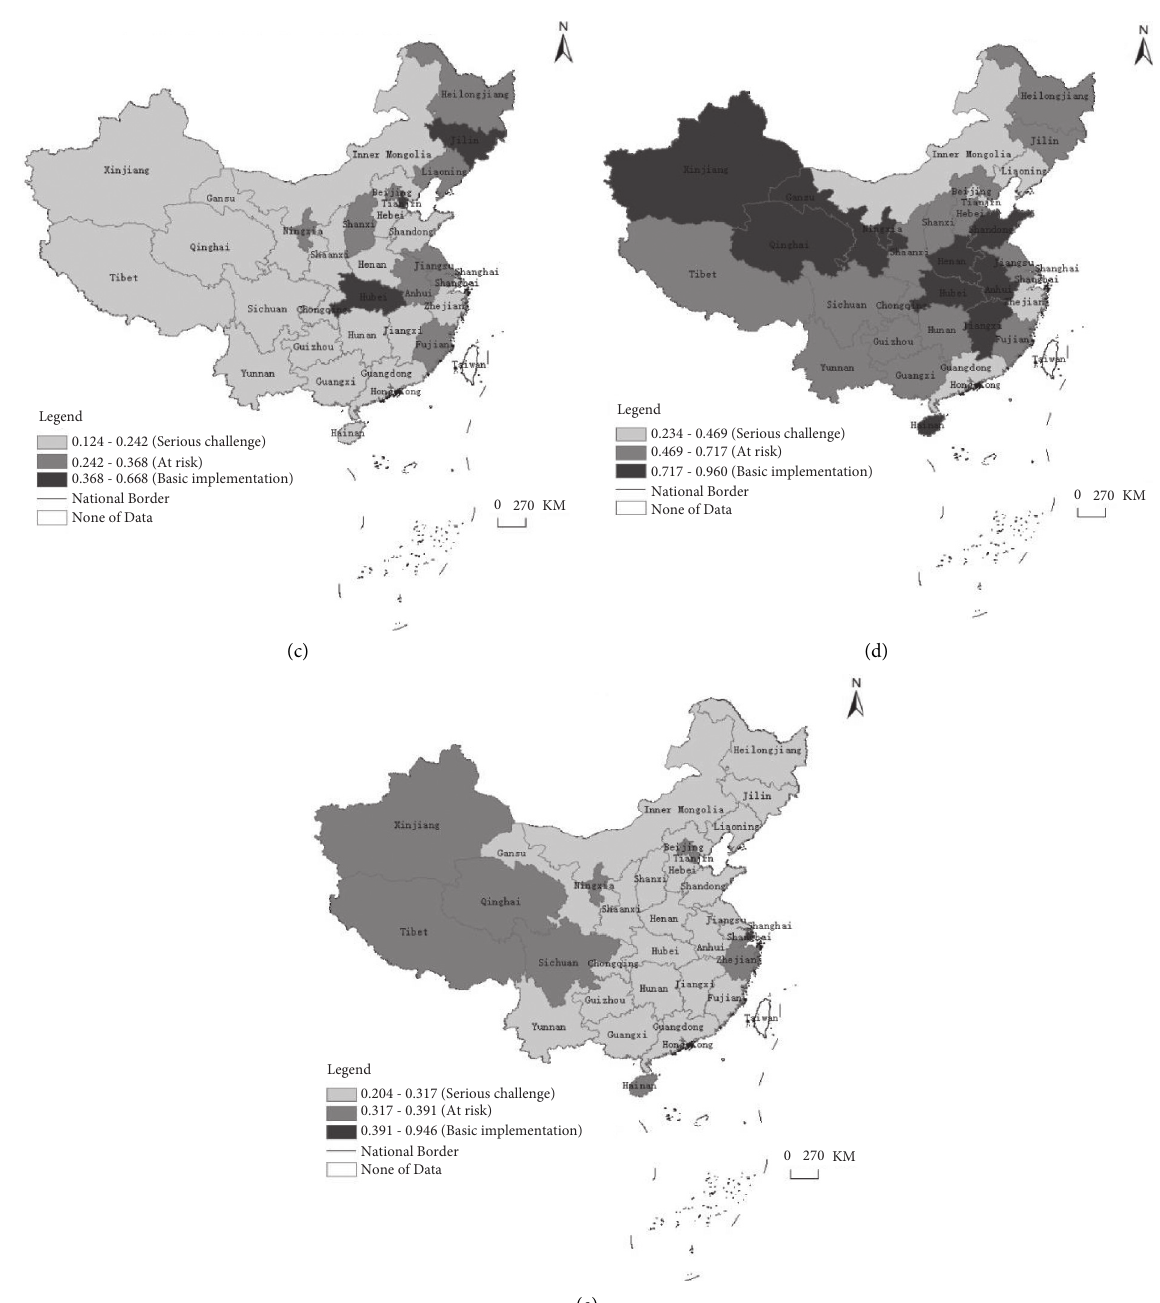
Figure 2: Grade division of the targets of the EIUR in 2018. (a) Grade division of full coverage. (b) Grade division of basic protection. (c) Grade division of flexibility. (d) Grade division of sustainability. (e) Grade division of